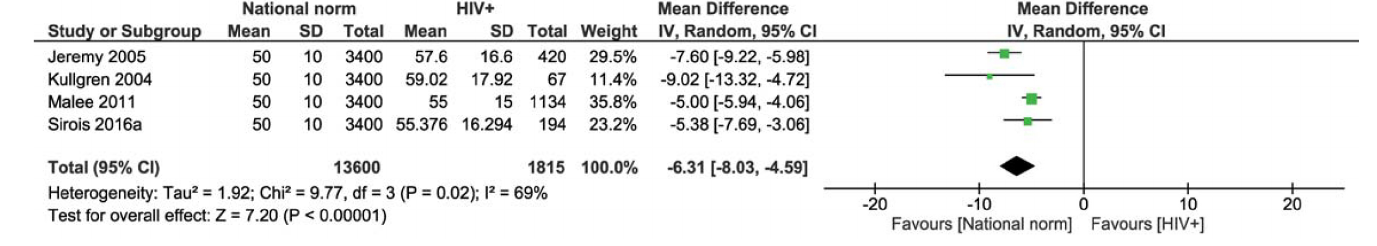
Fig 4. Learning scores of HIV-infected children compared to national norm